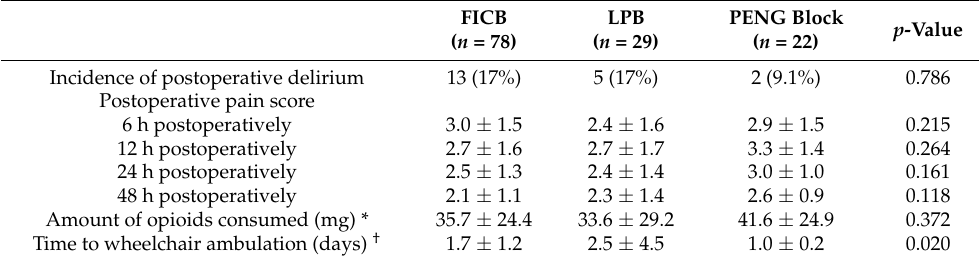
Table 5. Subgroup analysis for the postoperative pain score, incidence of delirium, amount of opioids consumed, and time to wheelchair ambulation between FICB, LPB and PENG block.